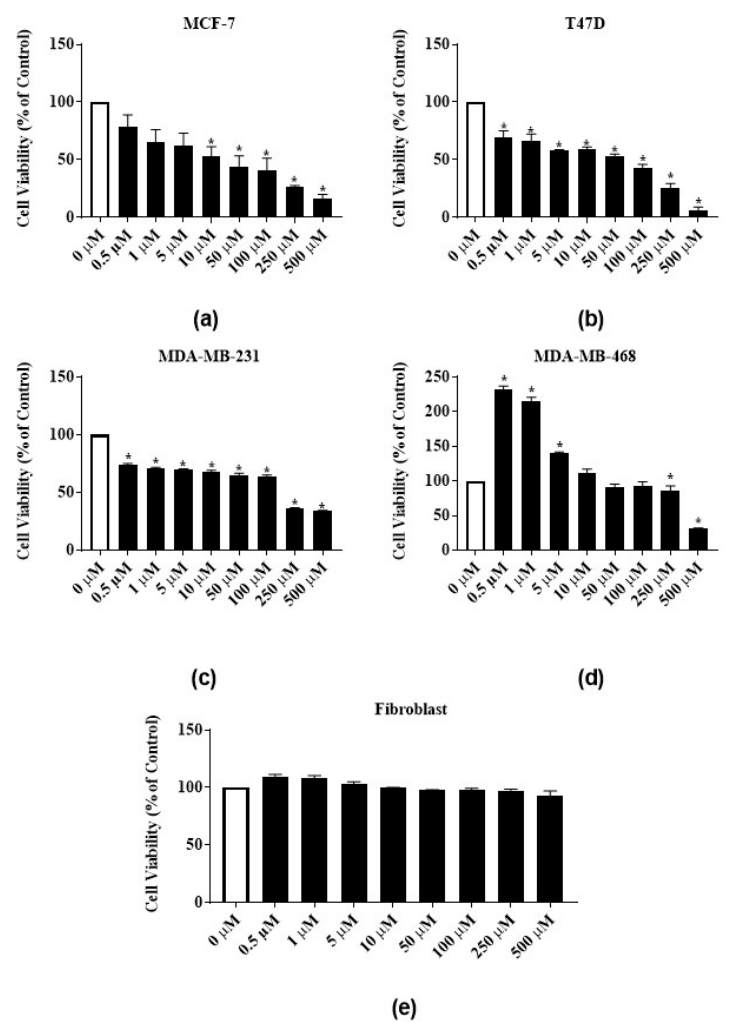
Figure 5. Antiproliferative activities of E . bicolor latex phytochemical rutin on ER-positive and triple negative breast cancer cell lines: ( a ) MCF-7 (ER+); ( b ) T47-D (ER+); ( c ) MDA-MB-231 (triple negative); ( d ) MDA-MB-468 (triple negative) breast cancer cell lines; and ( e ) effects of RTX on the growth of